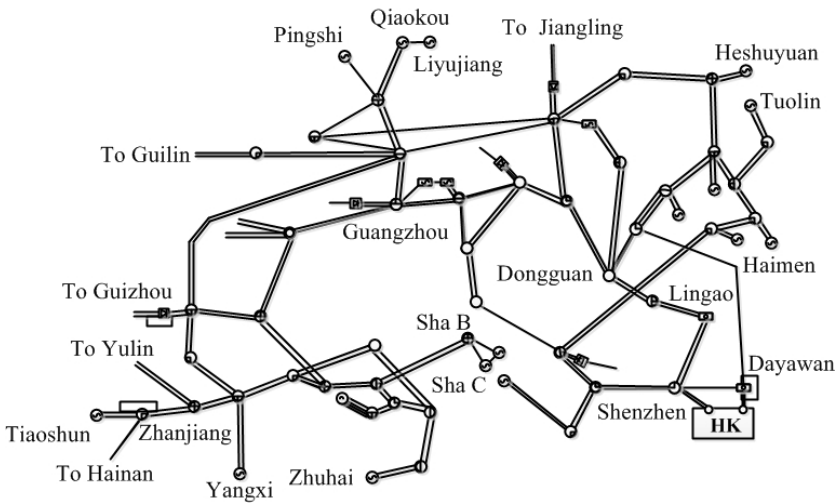
Figure 2. 500 kV main transmission network of the Guangdong power grid.